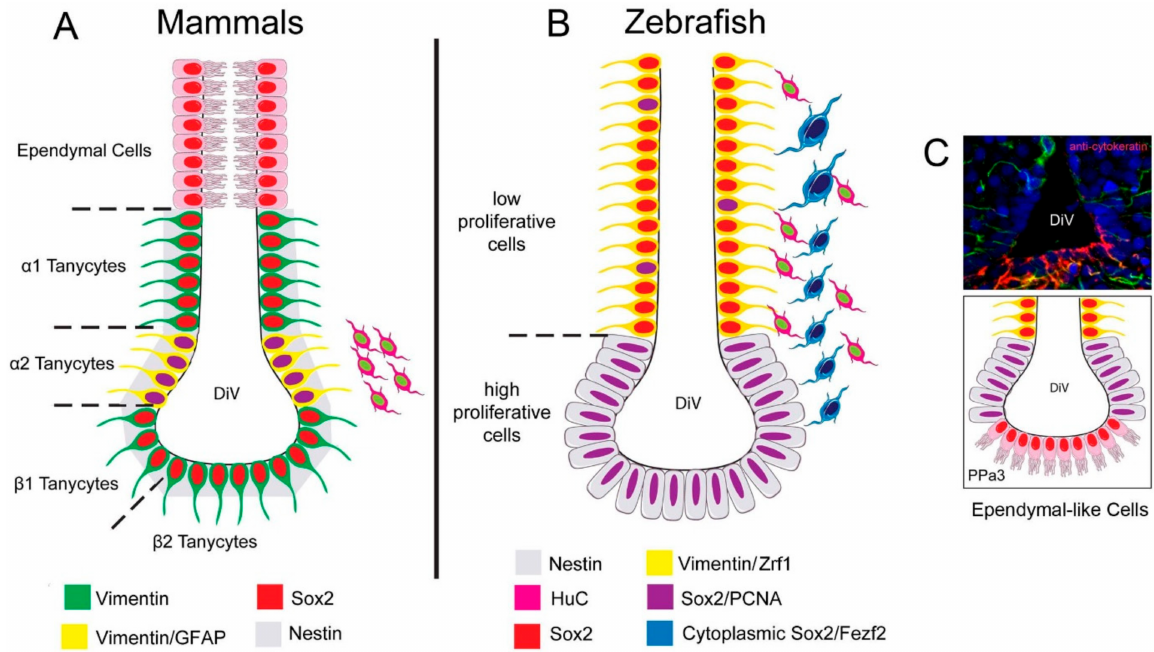
Figure 9. Summary of the distribution of neural progenitors in the POA. ( A ) Distribution of neural progenitors lining the DiV in the hypothalamus of mammals according to [17]. α 2 tanycytes with proliferative capacity express: Vim, Nestin [34], Sox2, and GFAP, while the non-proliferative tanycytes do not express GFAP. Ependymal cells are distributed in the dorsal region. ( B ) In zebrafish, we described a low-proliferative cell Vim+, Sox2+, and Zrf1+, and high proliferative Sox2+ cells, previously reported to express nestin [42]. Cytoplasmic Sox2/Fezf2:GFP cells were observed in the region previously shown to express cytoplasmic Sox2 [29]. ( C ) Cytokeratin cells are express in the ventral region of the POA in cytokeratin [43] positive ependymal-like cells similar to those seen in